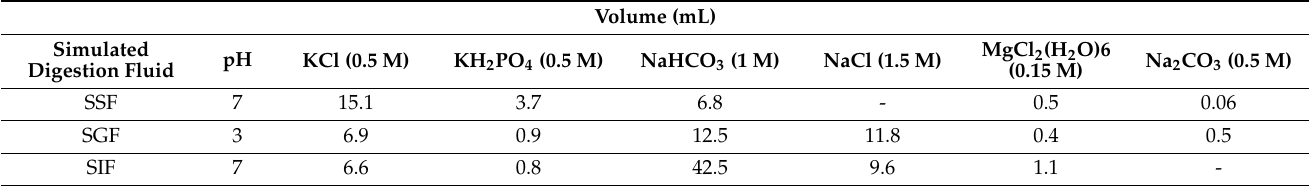
Table 1. Chemical composition of the buffer employed in the simulated digestion. SSF: salivary fluid; SGF: gastric fluid; SIF: intestinal